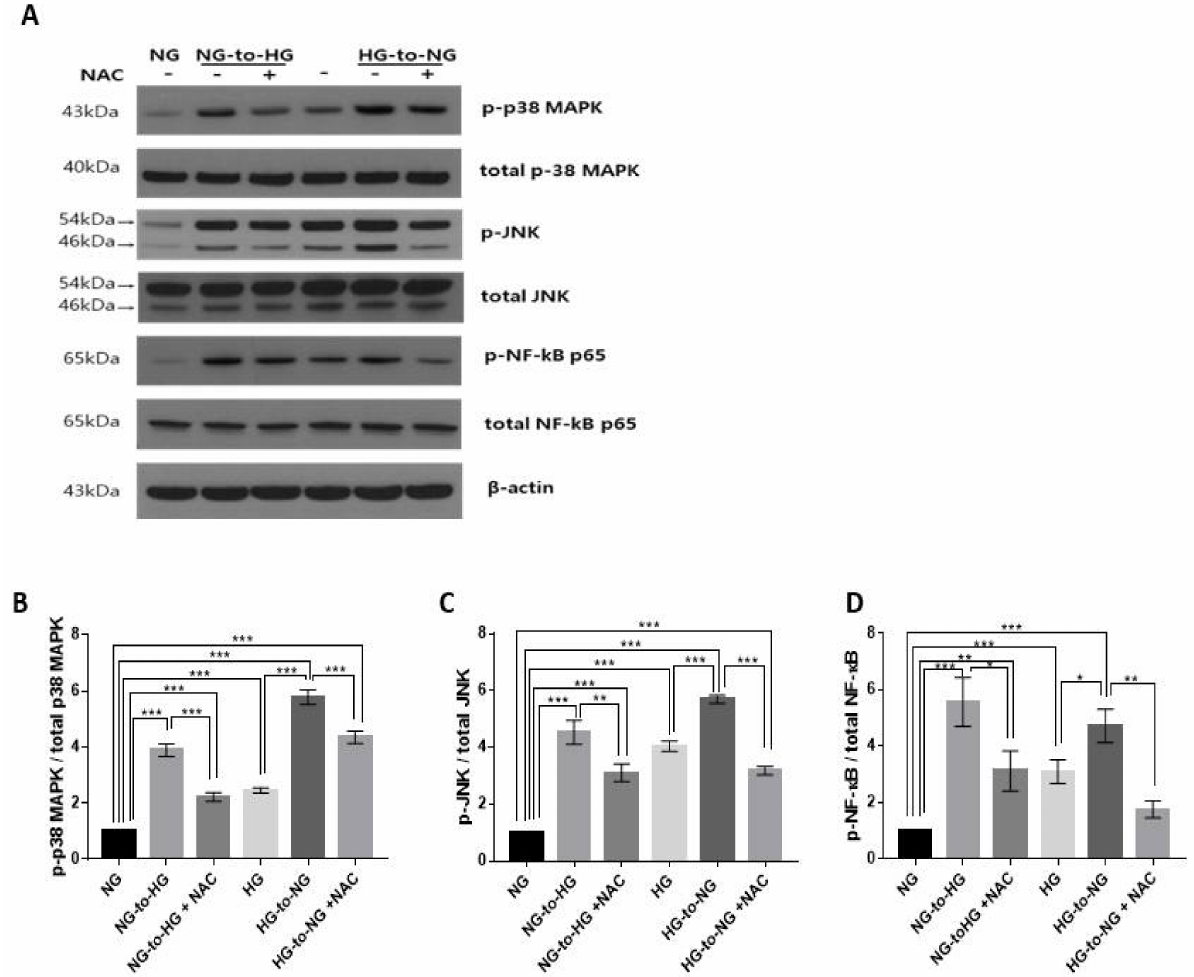
Figure 4. Acute glucose shift-induced ROS activates the p38 MAPK, JNK and NF- κ B signaling pathways. Before exposure of cells to an acute glucose shift, cells were pretreated with NAC (10 mM) for 1 h. Thereafter, cells were incubated under conditions of a glucose shift for 24 h. ( A ) Cell lysates were subjected to western blotting using antibodies against p-p38 MAPK, p-JNK, and p-NF- κ B; ( B – D ) The protein expression levels of p-p38 MAPK, p-JNK, and p-NF- κ B were quantified using ImageJ. Data are presented as the mean ± SEM from at least three independent experiments. * p < 0.05, ** p < 0.01, *** p <